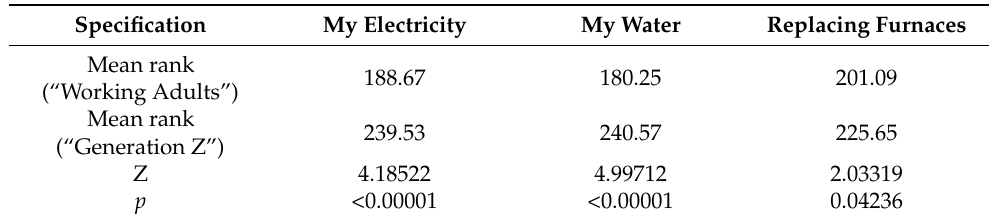
Table 3. Difference in participating in pro-environmental programs between “Working Adults” and “Generation Z” (Mann–Whitney test).